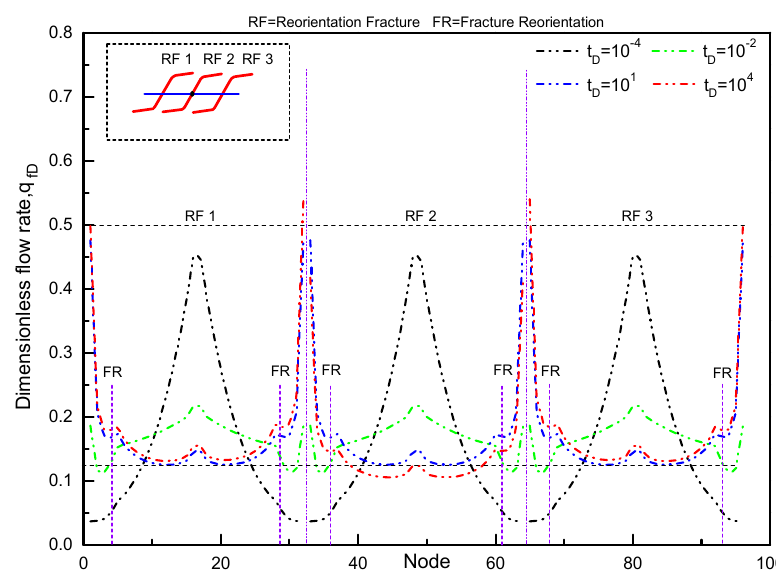
Figure 9. Rate distribution of a horizontal well with three reorientation fractures ( k x = 4 k y ). Table 1. Parameters used in Figures 8 and 9 for a horizontal well with three reorientation fractures. Basic Model